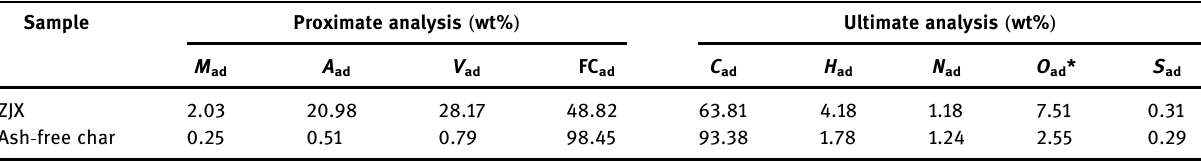
*Calculated by di ff